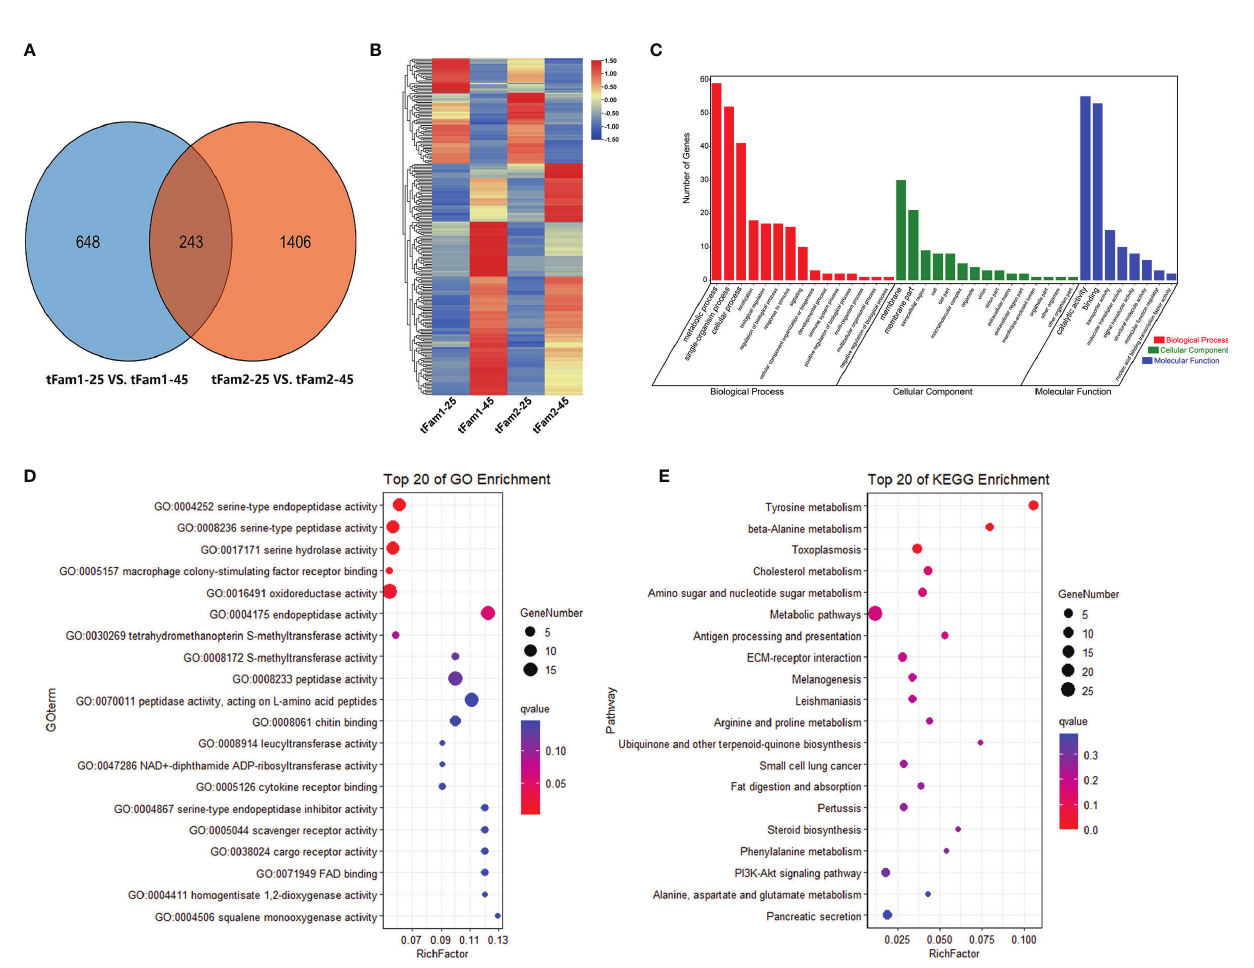
FIGURE 4 | DEGs shared by two high-salinity tolerant families after high-salinity stress in Litopenaeus vannamei . (A) Venn diagram of two pairwise comparisons for DEGs. (B) Gene expression heatmap of common DEGs. (C) GO enrichment analysis of common DEGs. (D) Top 20 GO terms enriched in the categories of molecular function for common DEGs, the point color shows different Q values as indicated on the right, and red color represents the signi fi cantly enriched GO term (Q < 0.05). (E) Top 20 KEGG pathways enrichment for common DEGs, the point color shows different Q values as indicated on the right, and red color represents the signi fi cantly enriched GO term (Q < 0.05). DEGs, differentially expressed genes; GO, Gene Ontology; KEGG, Kyoto Encyclopedia of Genes and